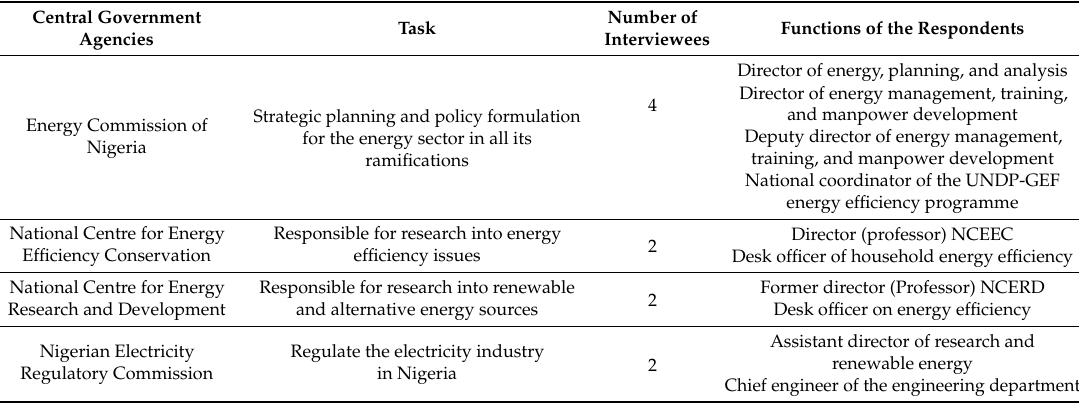
Table 2. Information on interviewees, their functions and organizations.